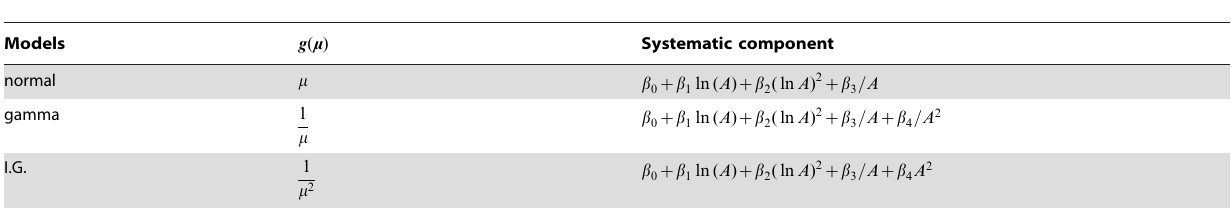
Table 2. The GSAMs fitted with different models according to the likelihood method.